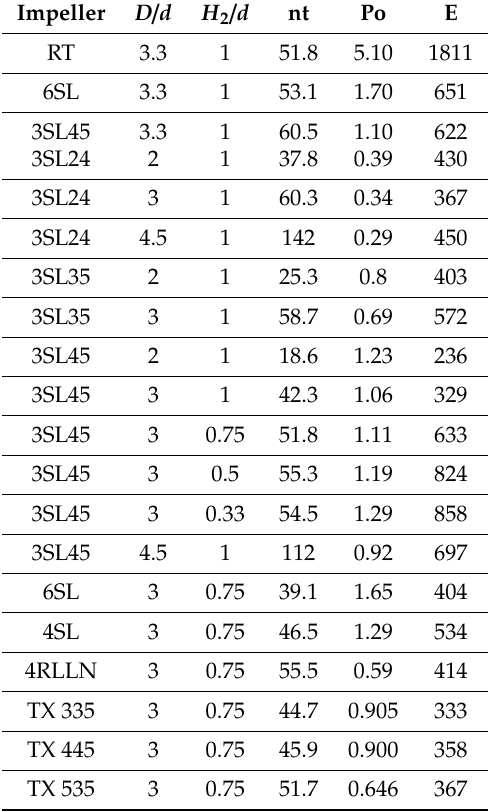
Table 5. Dimensionless energy necessary to achieve the required degree of homogeneity of impellers in a cylindrical vessel with radial ba ffl es